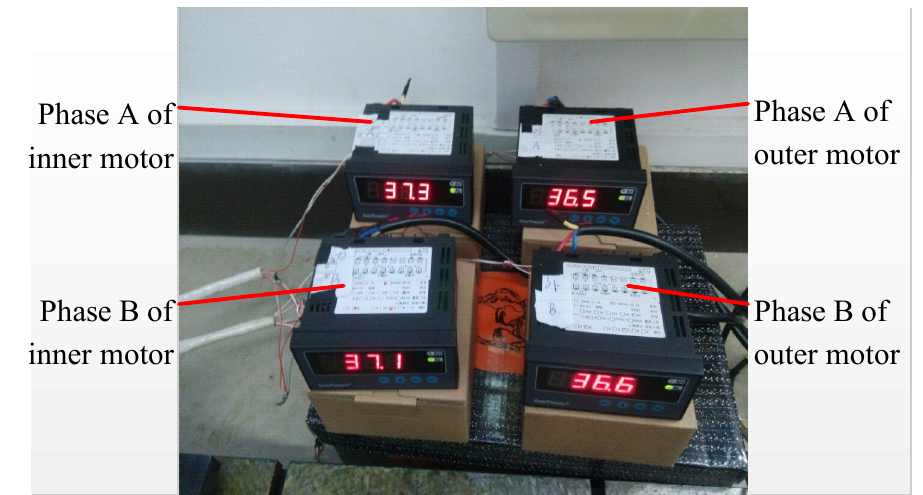
Figure 28. The positions of thermistors.